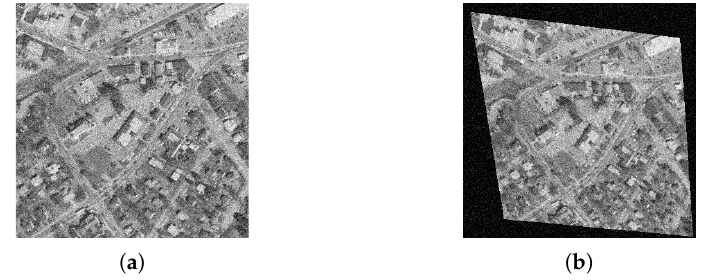
Figure 14. West Concord image pair. ( a ) Reference image. ( b ) Sensed image.